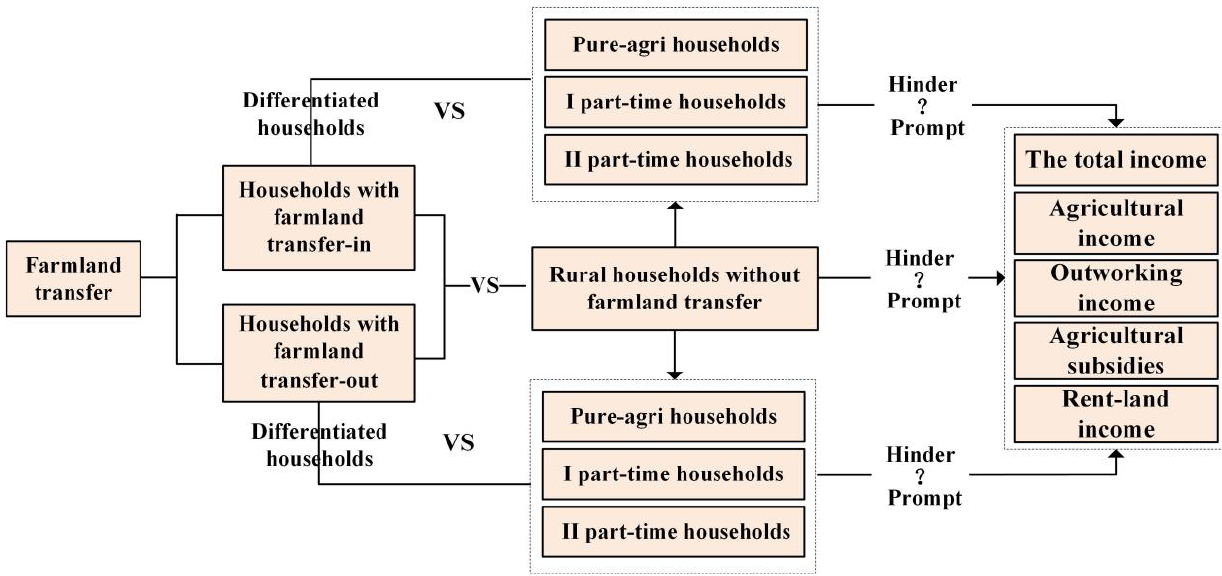
Figure 2. Structure of the analysis of the impacts of farmland transfer on rural households’ income. By eliminating the abnormal data of indicators needed in this study, we finally se- lected 484 households who did not transfer their farmland, and 304 who transferred their farmland; of these last, 178 and 126 were transferred-in and transferred-out, respectively. In terms of household type, our sample included 259 pure-agricultural, 119 I part-time, and 106 II part-time rural